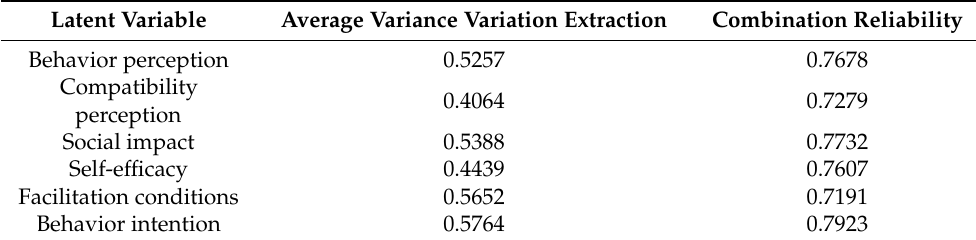
Table 5. Test results of convergence validity of the scale.